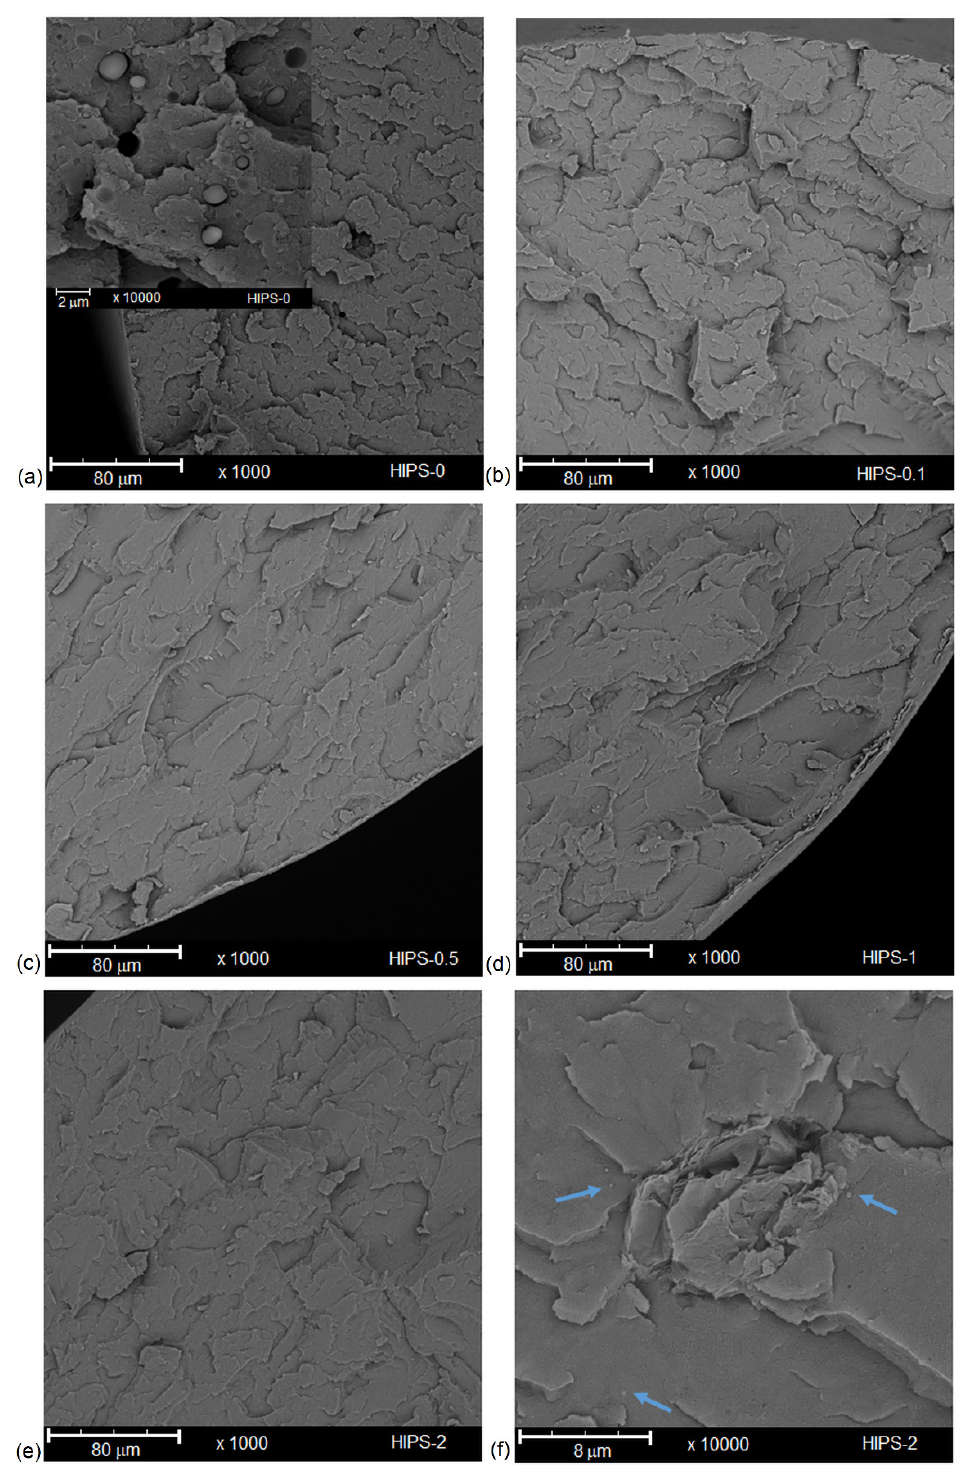
Figure 2. Cross-section of HIPS-0 and HIPS composites: HIPS-0 ( a ); HIPS-0.1 ( b ); HIPS-0.5 ( c ); HIPS-1 ( d ); HIPS-2 ( e , f ).